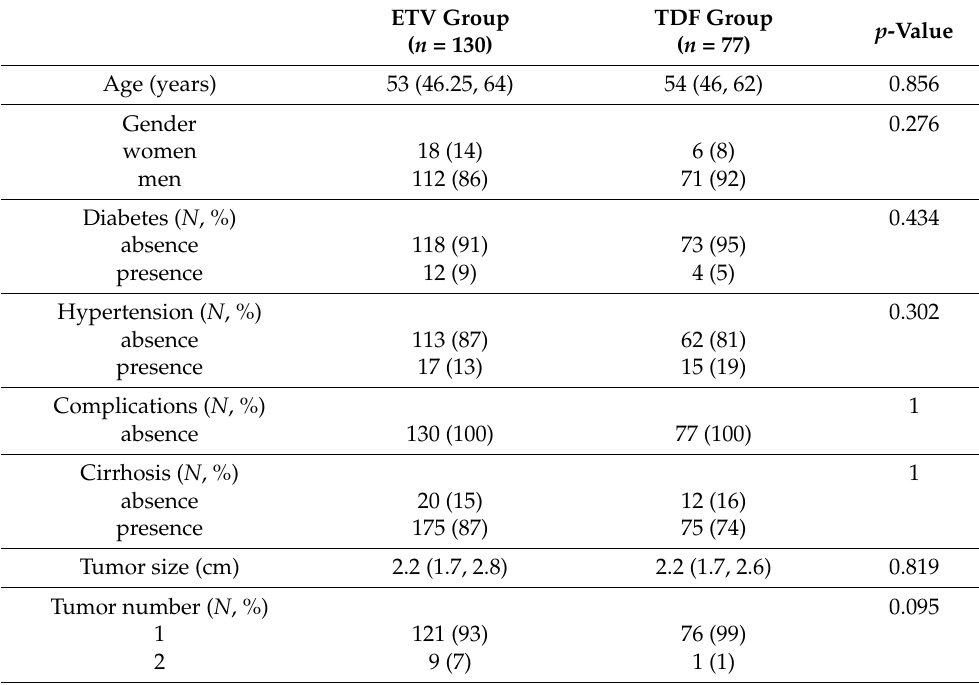
Table 2. Baseline characteristics of patients ( n = 207) after